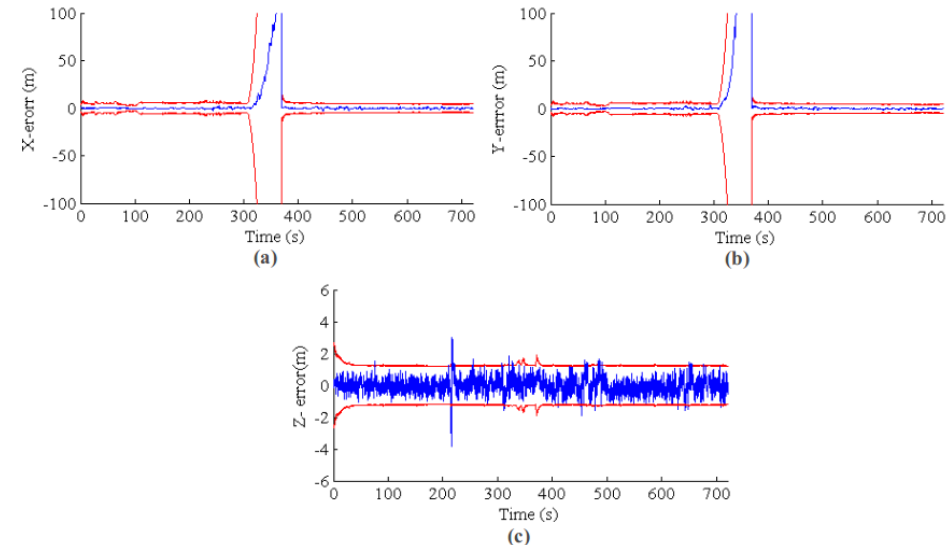
Figure 18. EKF state estimation without the VO update for GPS outage from 300 s to 360 s. Both the error and error covariance are sharply increasing due to the noisy IMU integral. ( a – c ) The results for X , Y and Z , respectively. The blue line is the position error, and the red line is the 3 σ error band from the state covariance.